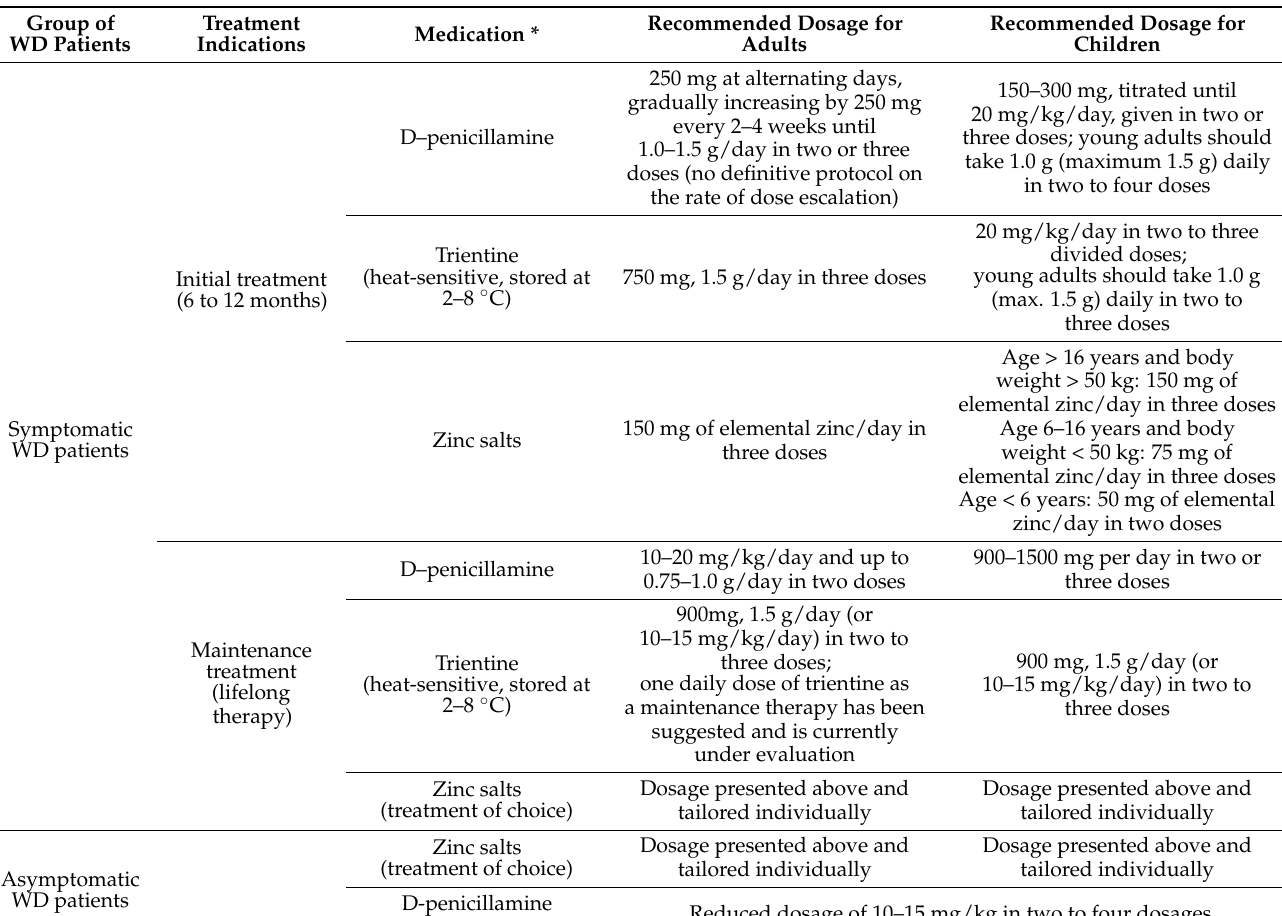
Table 3. Adult and child dosages of currently available treatments for Wilson’s disease